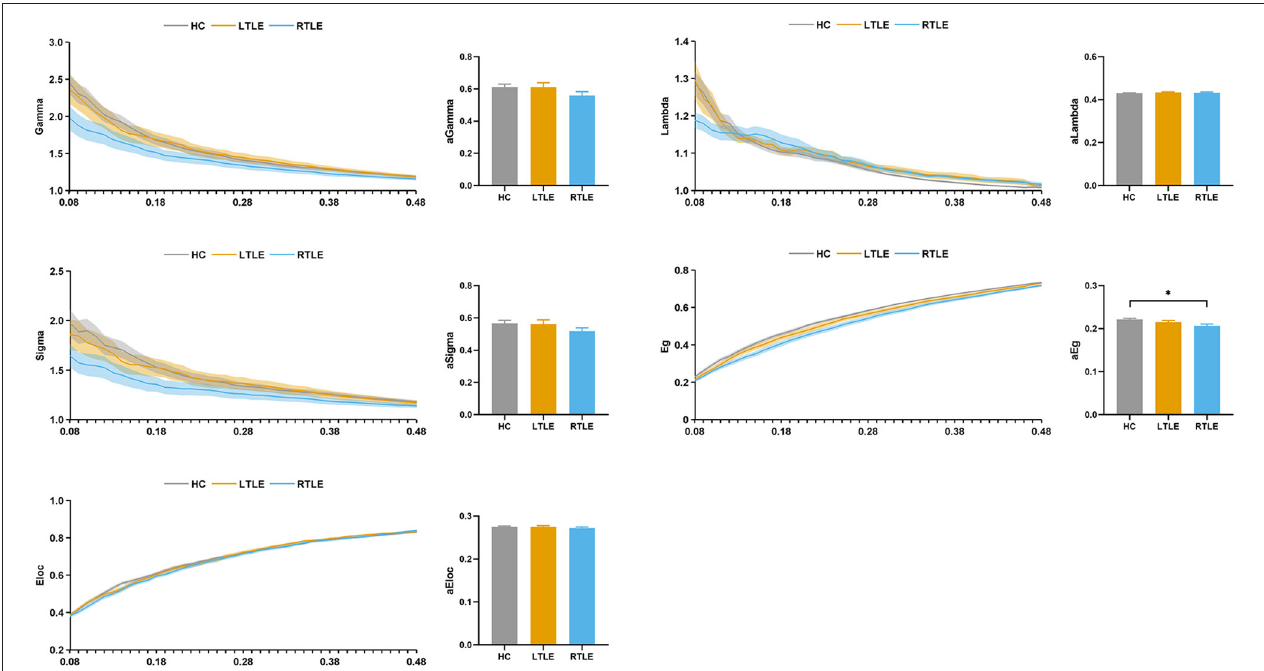
FIGURE 4 | Global topological properties in static functional connectivity. The left column represents the small-world properties and network efficiency across the sparsity range 0.08–0.48. Straight lines show the average, and the corresponding transparent areas indicate the standard error. The right bar demonstrates the group effect of AUC. The horizontal lines above the bars indicate comparisons that achieved statistically significant thresholds (* P < 0.05, Bonferroni corrected). Gamma, normalized clustering coefficient; Lambda, normalized characteristic path length; Sigma, small-worldness index; Eg, global network efficiency; Eloc, local network efficiency.